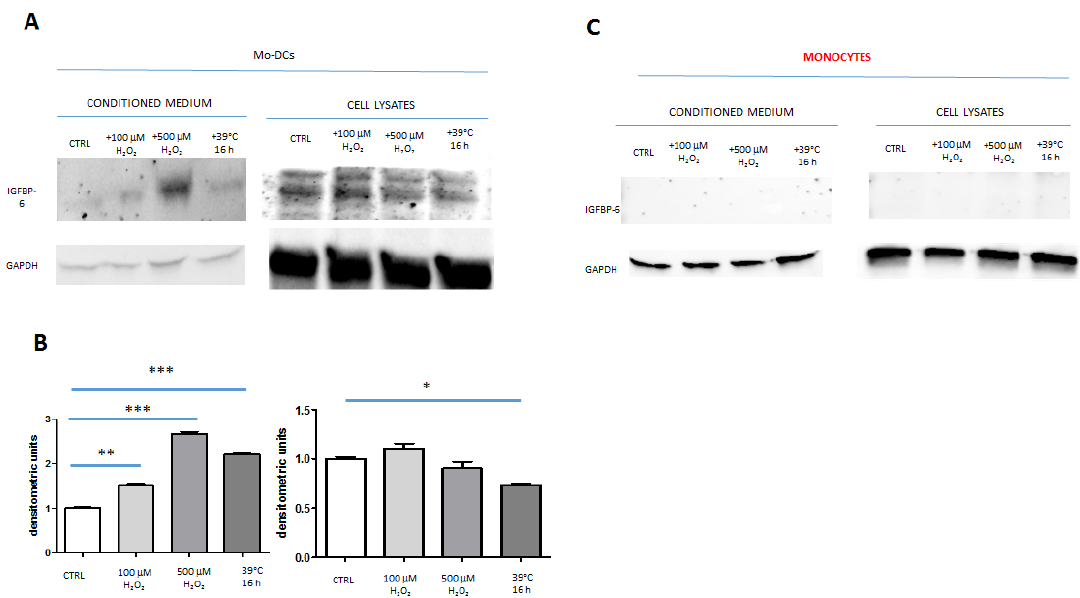
Figure 3. Hyperthermia and H 2 O 2 stimulate IGFBP-6 secretion by Mo-DCs. ( A ) Western Blotting of IGFBP-6 and GAPDH on conditioned medium and cell lysates of Mo-DCs. ( B ) Densitometric analysis of IGFBP-6 normalized to GAPDH. Intensity of IGFBP-6 at 37 ◦ C for the whole experiment length (CTRL) was put to 1 as reference. The left and right graphs correspond to results obtained with conditioned medium and cell lysates, respectively. The results are shown as mean ± SD of two experiments. ( C ) Western Blotting of IGFBP-6 and GAPDH on conditioned medium and cell lysates of monocytes * p < 0.05; ** p < 0.01; *** p < 0.0001.